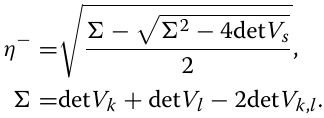
0.2 ω m . The other parameters are � 1 0 and b (cid:31) = =